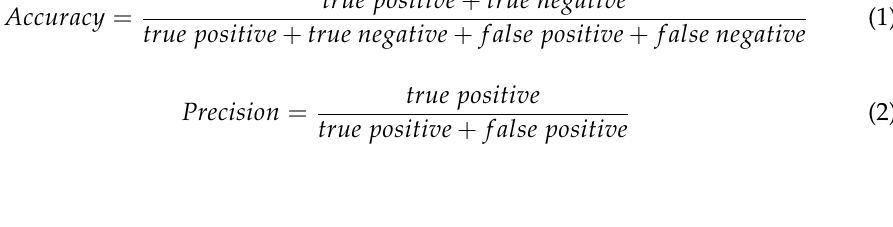
Figure 8. Dataset distribution.